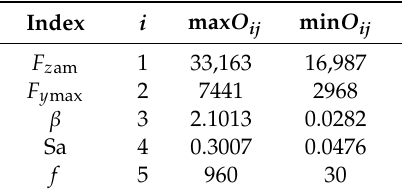
Table 6. The max O ij and min O ij values of each